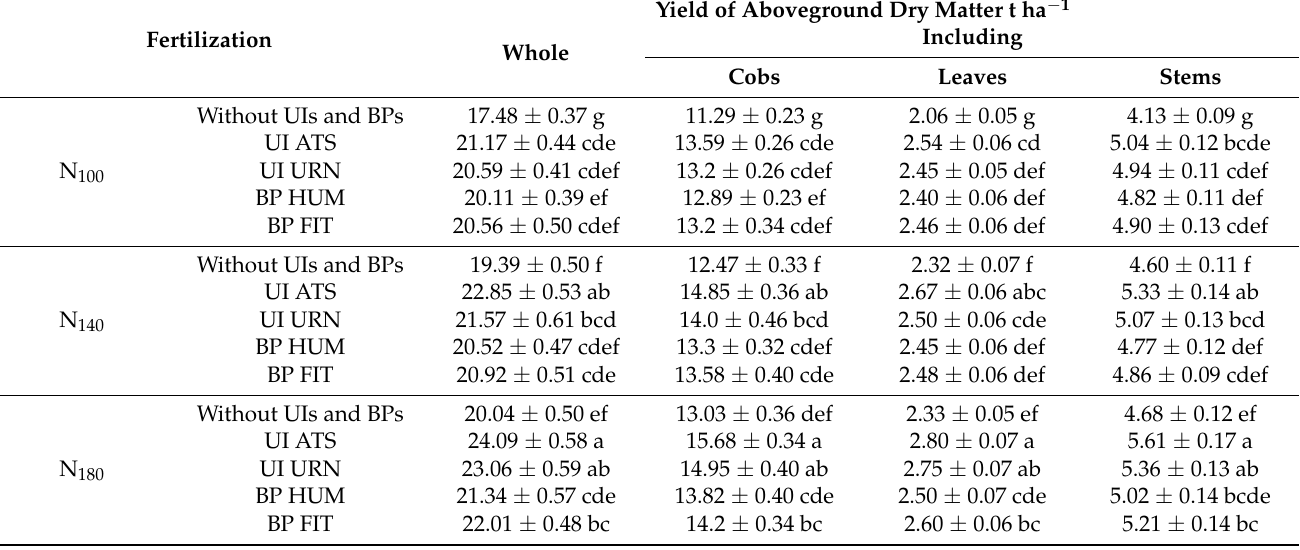
Table 6. The influence of different nitrogen fertilizer rates, urease inhibitors, and biological prepara- tions on the dry matter yield and yield structure of maize in